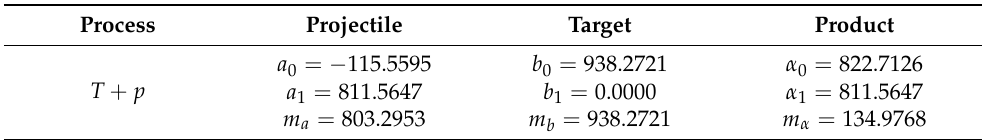
Table 3. Case TBB Solution 1 (in MeV/ c 2 with c set to 1) with Equations (51) and (52) satisfied up to four digits after the decimal shown. See text for details.